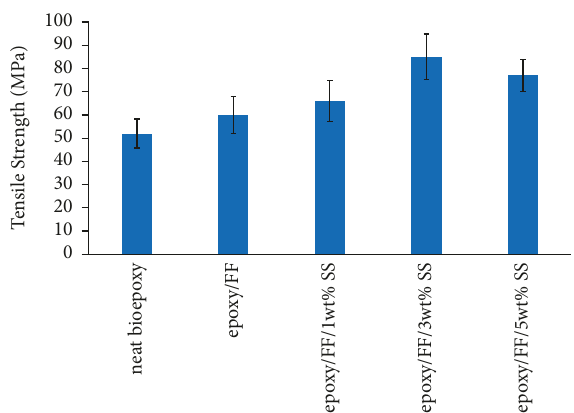
Figure 5: Tensile strength of pristine biobased epoxy and biobased epoxy reinforced by FF and various weight fractions of SS.